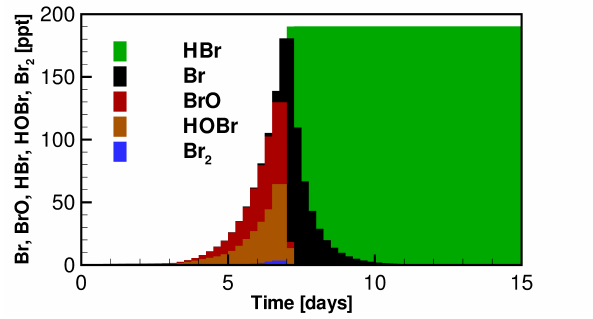
Fig. 2. Temporal evolution of the mixing ratios of ozone and bromine using the bromine only mechanism for a boundary layer height of